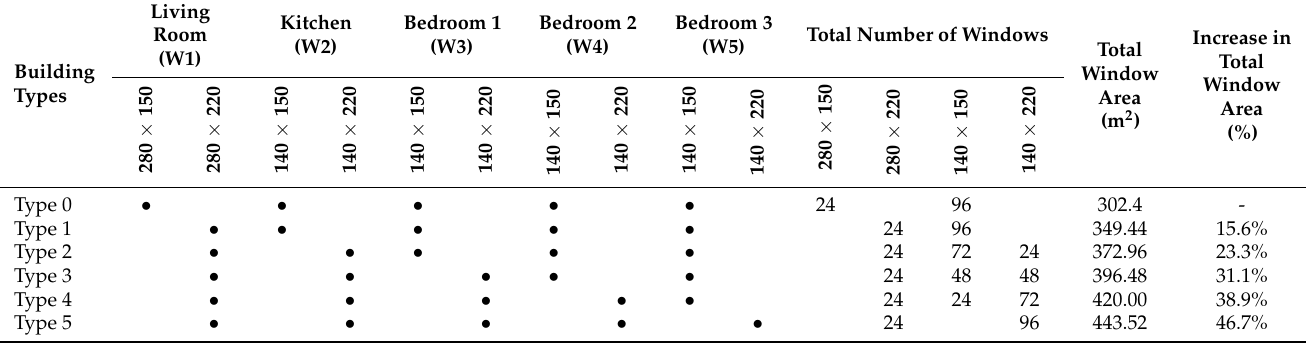
Table 3. Building types according to window size.